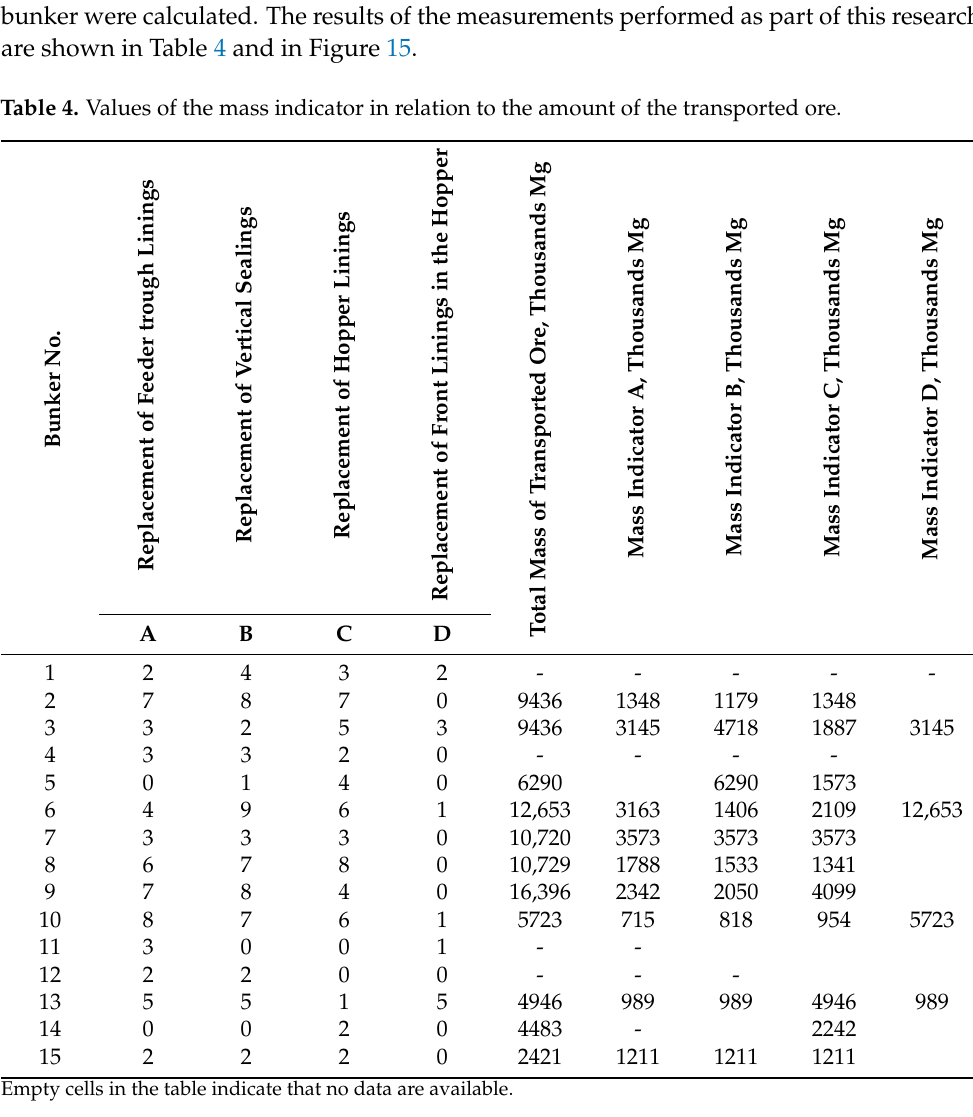
Figure 14. Different types of the transported ore: ( a ) large rock lumps, ( b ) dry ore, ( c ) moist ore.